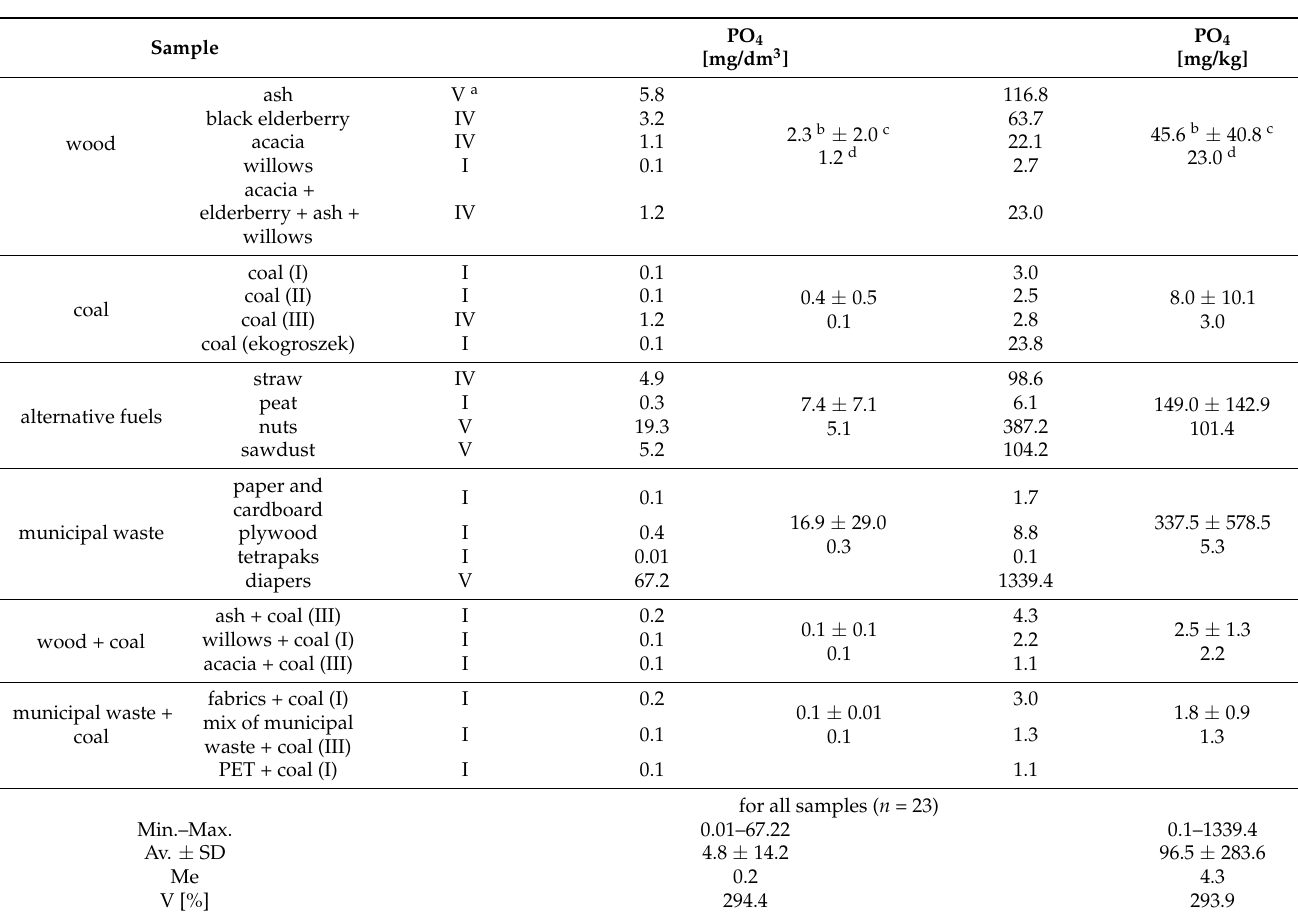
Table 4. Statistical parameters for water leaching of phosphates from